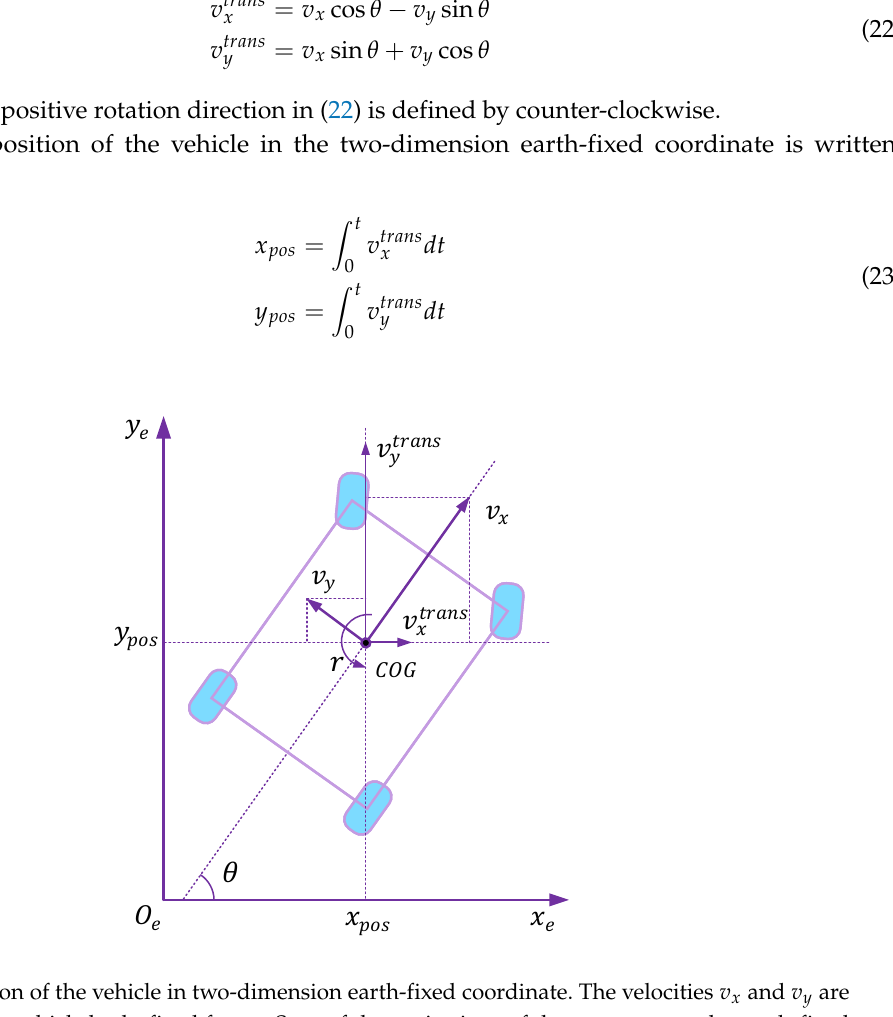
Figure 7. Position of the vehicle in two-dimension earth-fixed coordinate. The velocities v x and v y are associated with vehicle body-fixed frame. Sum of the projections of these vectors on the earth-fixed coordinate ( Oxy ) e are v trans x and v trans y , which are then used for the position model of the